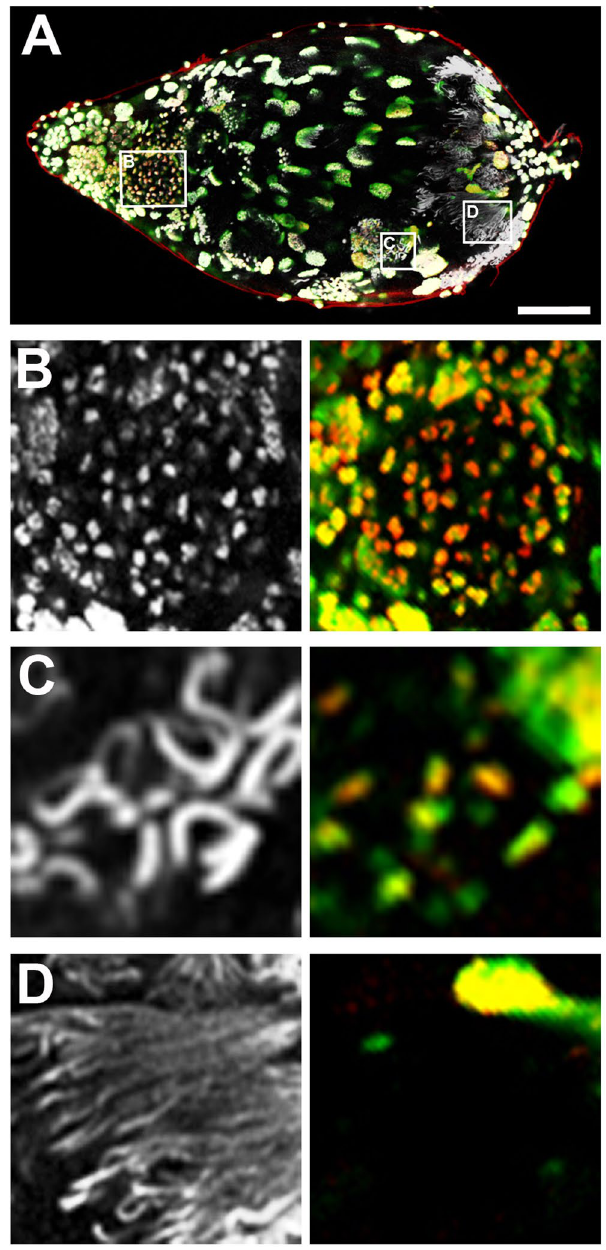
Figure 6. Histone removal during spermiogenesis. In all panels, DNA is grey, green is pan histones, and red is H3K9me3. ( A ) Testis from a yellow-black male pupa. ( B ) A cyst of dividing germ cells located toward the testis’ anterior end. The chromatin of these cystocytes contains histones and H3K9me3. ( C ) A group of individualizing spermatids showing reduced levels of histones and H3K9me3 in small regions in each spermatid. ( D ) Individualized sperm, showing no traces of histones and H3K9me3. Scale bar in ( A ) is 75 μ